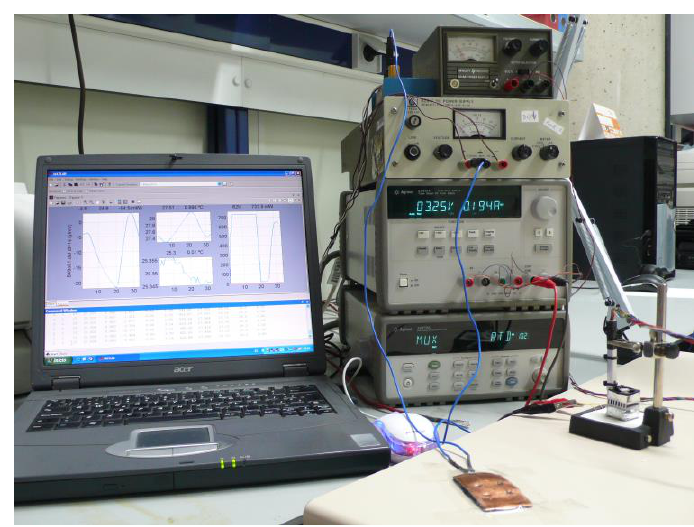
Figure 3. Measurement and control instrumentation.